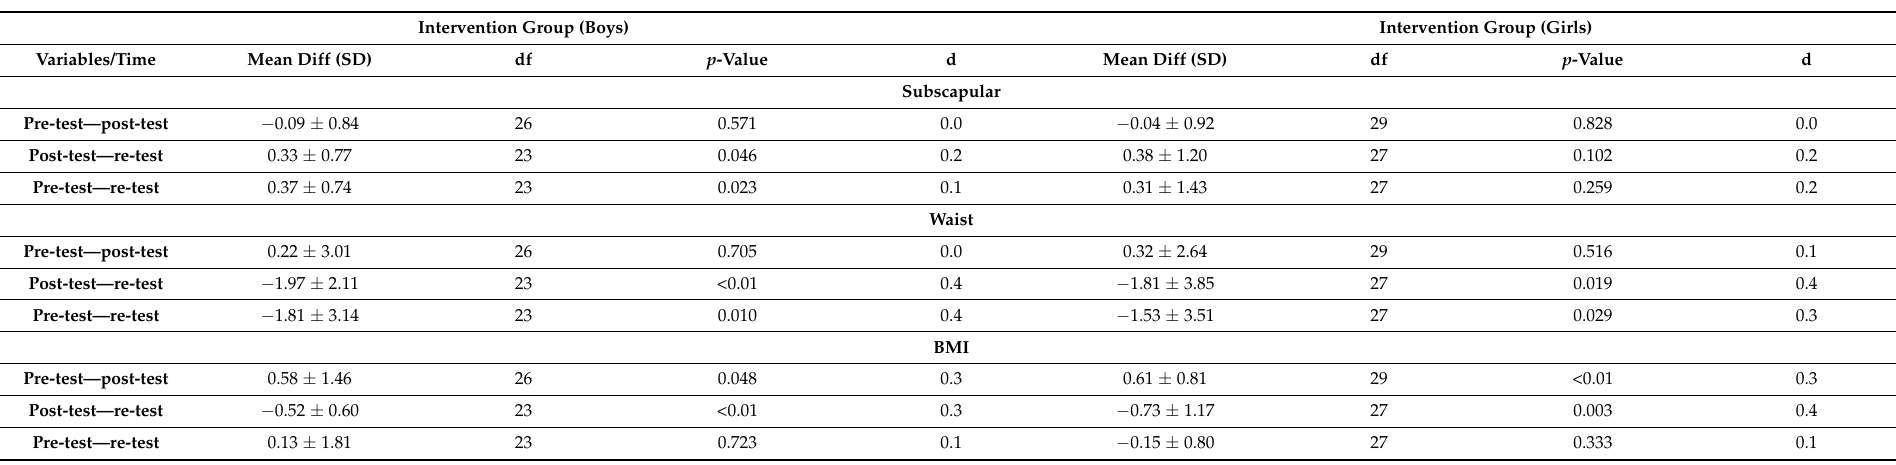
Table 3. Effect size of changes between measurements for all anthropometric and body-composition variables in both groups. Intervention Group